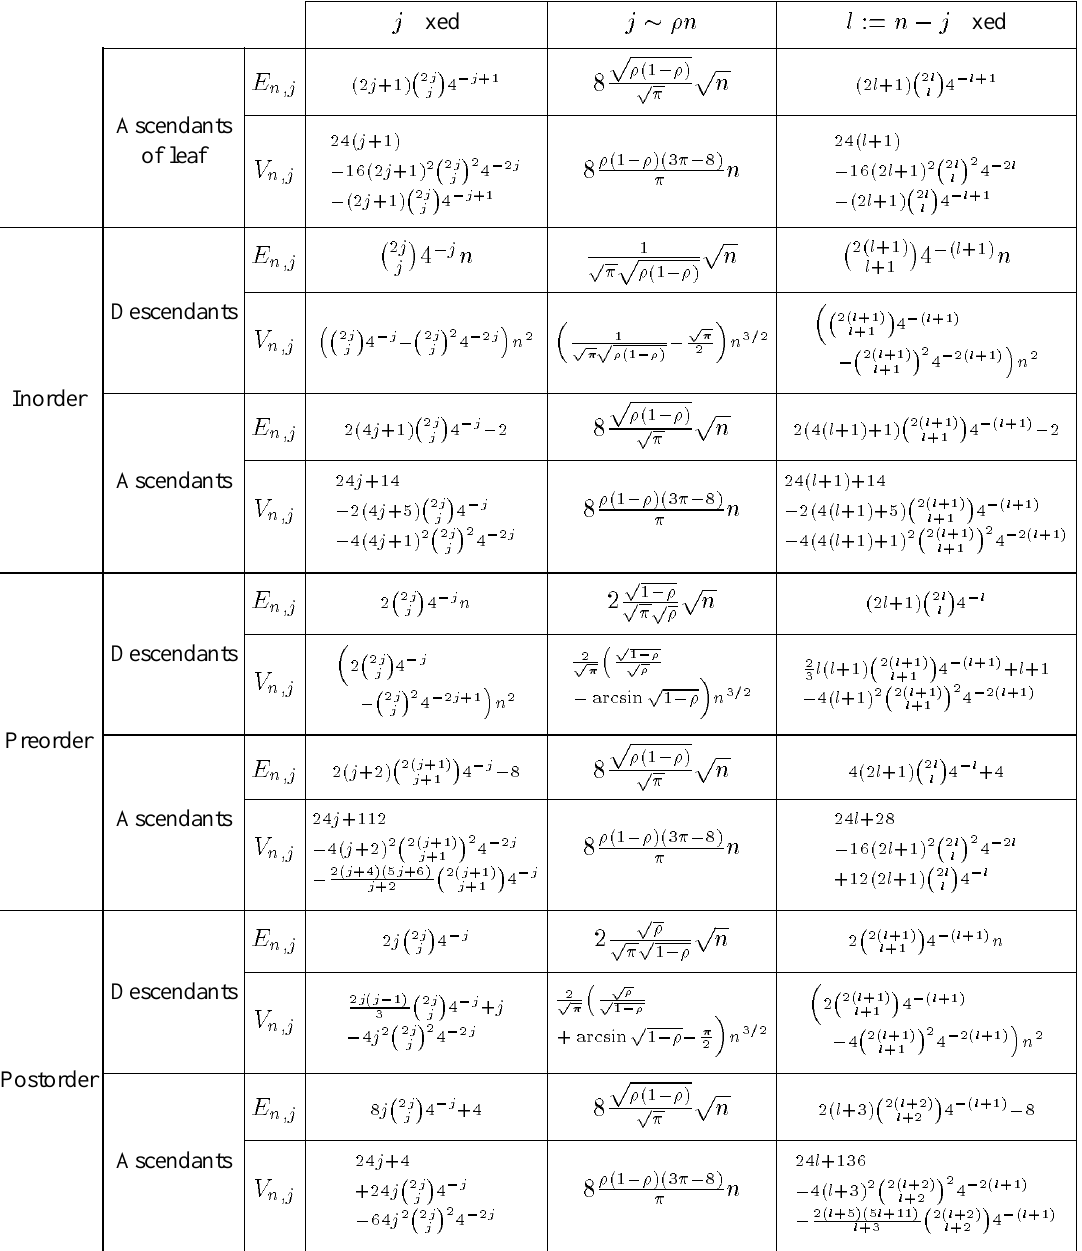
Tab. 1: Asymptotic results related to all the explicit formulæ in the paper j